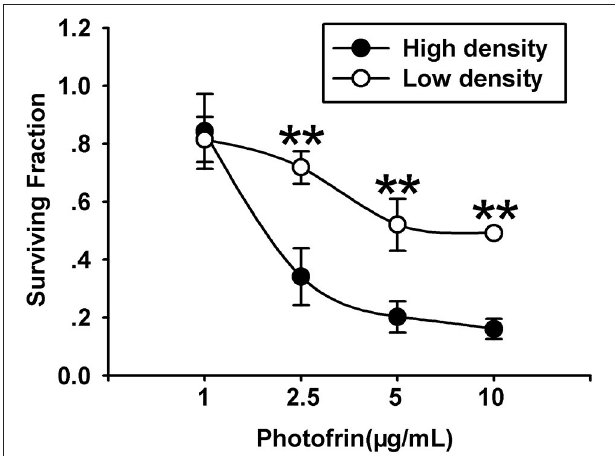
FIGURE 1 | PDT Phototoxicity depends on the cell density. CCK-8 assay was utilized to measure cell survival after PDT under high- or low-density conditions. Data points are mean ± SD from 4 to 7 independent experiments. t- test was used to assess statistically significant differences between groups. ** P < 0.01, significantly different from high-density